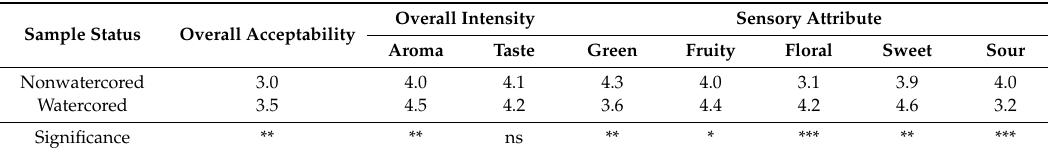
Table 1. Sensory evaluation for watercored and nonwatercored ‘Fuji’